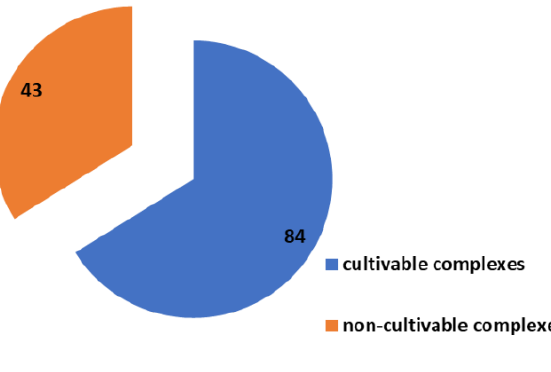
Figure 6 . Morphologic evaluation of cumulus-oocyte complexes.